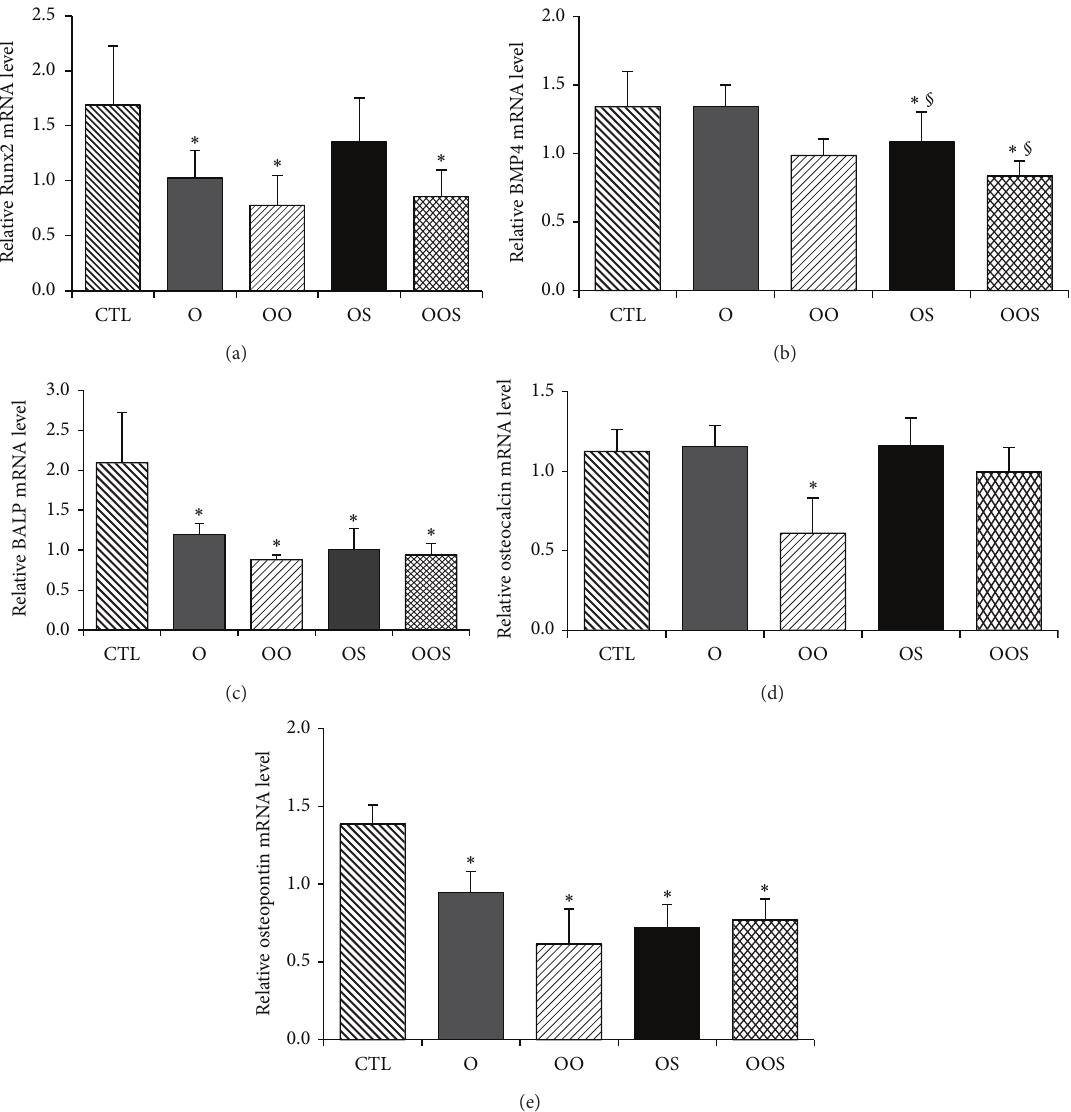
Figure 1: Expression of (a) Runx2, (b) BMP4, (c) ALP bone isoform d, (d) osteocalcin (OCN), and (e) osteopontin (OPN) in osteoblasts as measured by quantitative real-time PCR. Cells were grown in presence of sera from healthy normal body weight control individuals (CTL); obese patients (O); obese osteopenic patients (OO); obese sarcopenic patients (OS); obese sarcopenic osteopenic patients (OSO) as